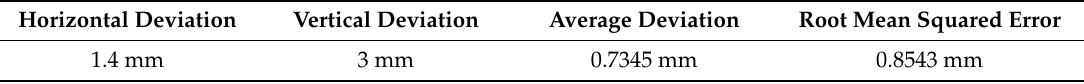
Table 3. Trajectory sampling analysis